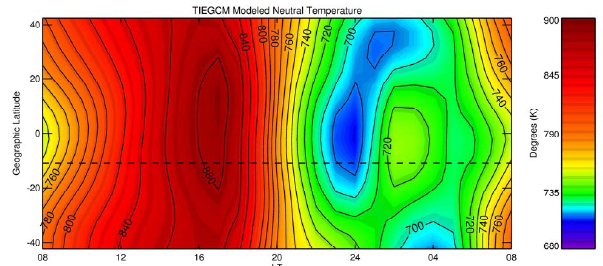
Figure 9. Fig. 9. TIEGCM modeled neutral temperature. A weak MTM fea- ture can be seen approximately centered on the geographic equator near 03:00 LT. The dashed line indicates the location of the geo- magnetic